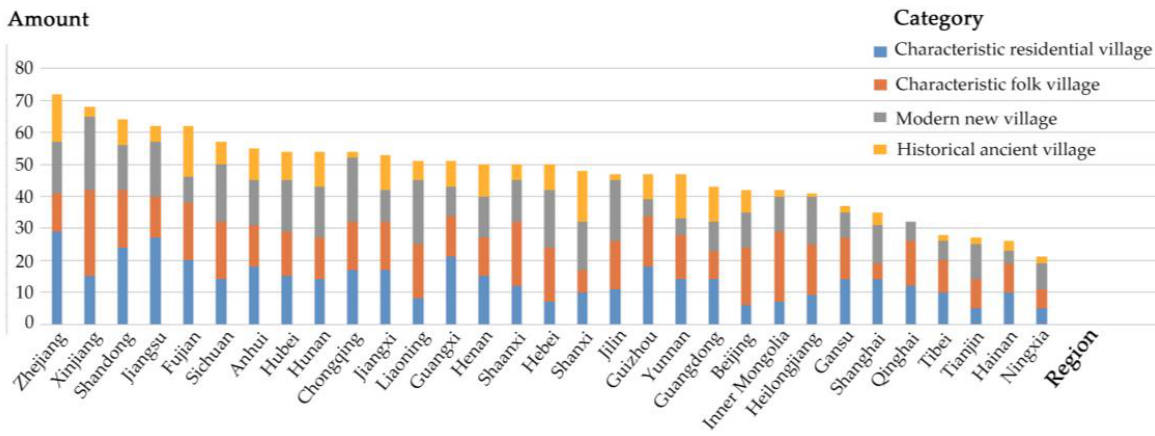
Figure 4. Regional distribution of the classification of beautiful leisure villages in China.